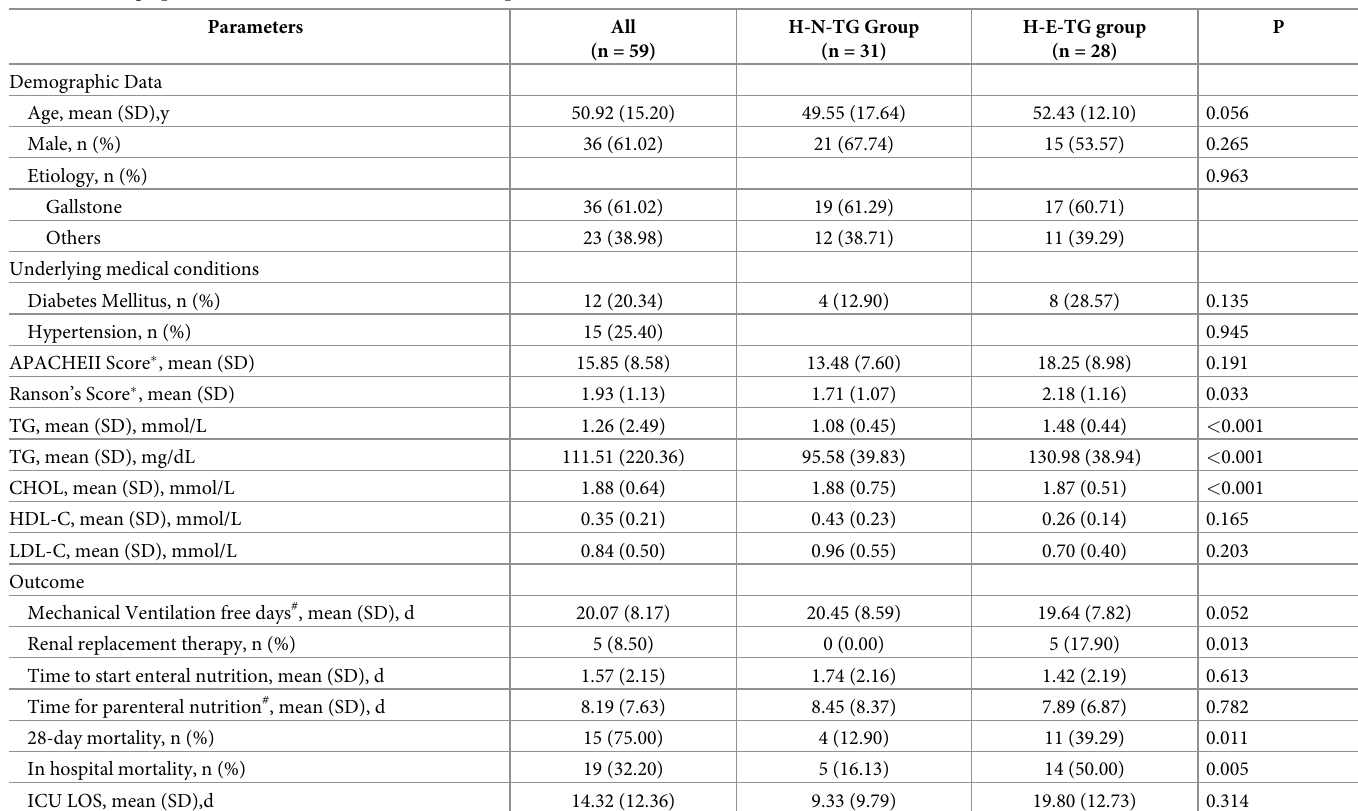
Table 2. Demographics, clinical and outcome data of N-TG patient